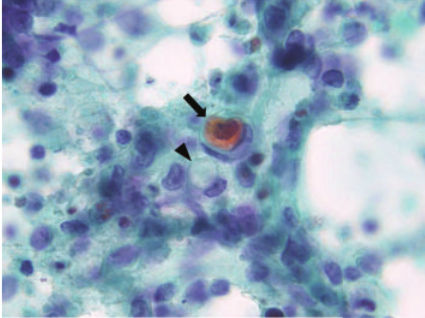
Figure 3: Papanicolaou-stained smear showing pearl formation. A few cells showed overt pearl formation, including a dyskeratocyte (arrow), implying keratinization. Occasional cells with moderately delicatecytoplasmandcytoplasmiccoarsevacuoles(arrowhead)are